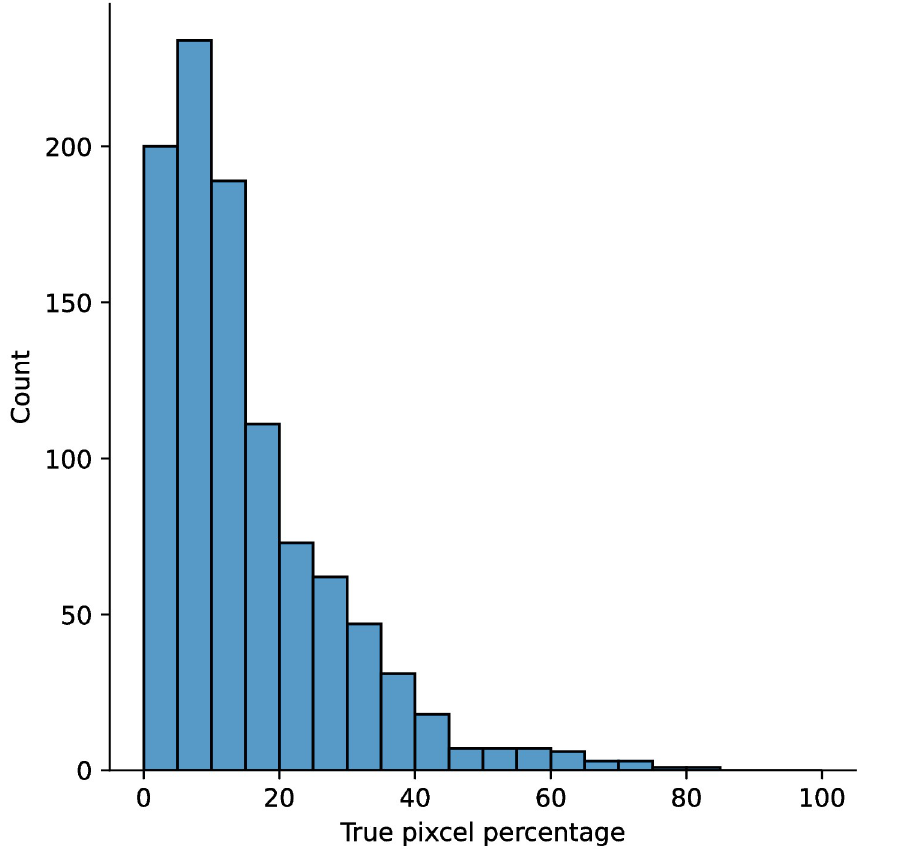
Fig 3. Distribution of true pixel percentages of the full image size of polyp masks in HyperKvasir [51].